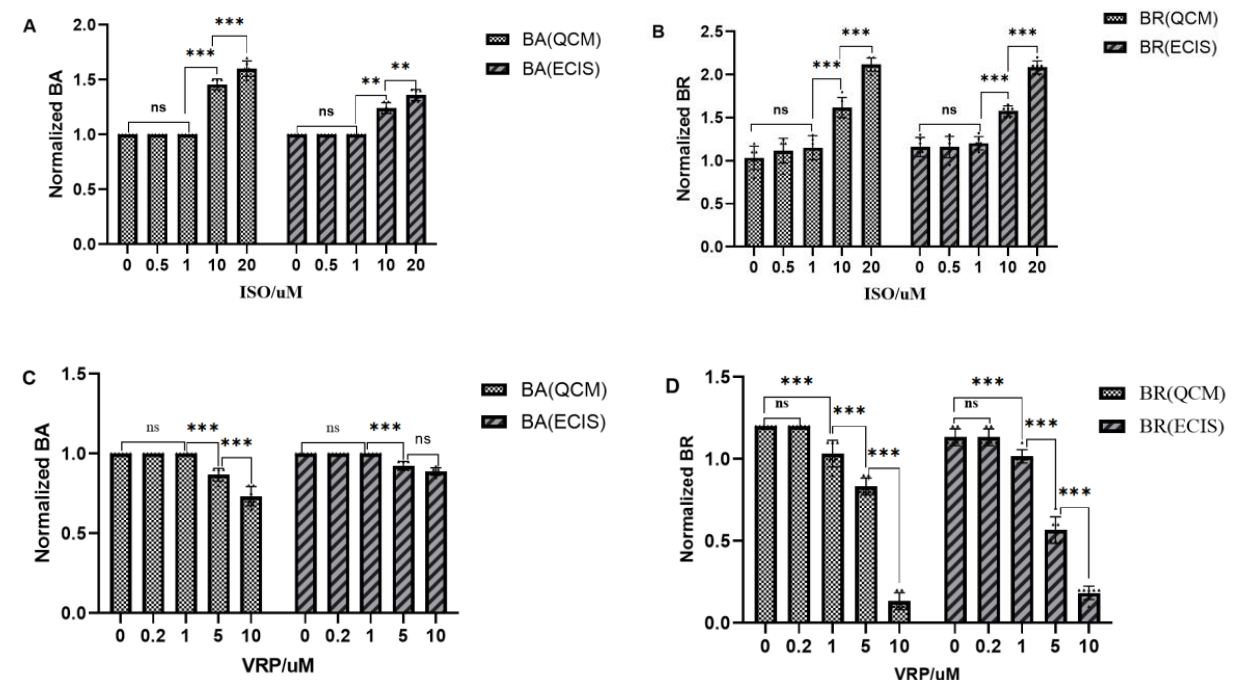
Figure 9. Plot showing the response characteristics of the QCM and EIS in the cardiomyocytes after 6 h of drug action (Mean ± SD, n = 6) ( A ) Response of the characteristic BA parameter to the different concentrations of ISO; ( B ) Response of the characteristic BR parameter to the different concentrations of ISO ( C ) Response of the characteristic BA parameter to the different concentrations of VRP; ( D ) Response of the characteristic BR parameter to the different concentrations of VRP. (the value bars with ns are not significant, asterisk denotes statistically significant differences * p < 0.05; ** p < 0.01; *** p < 0.001)